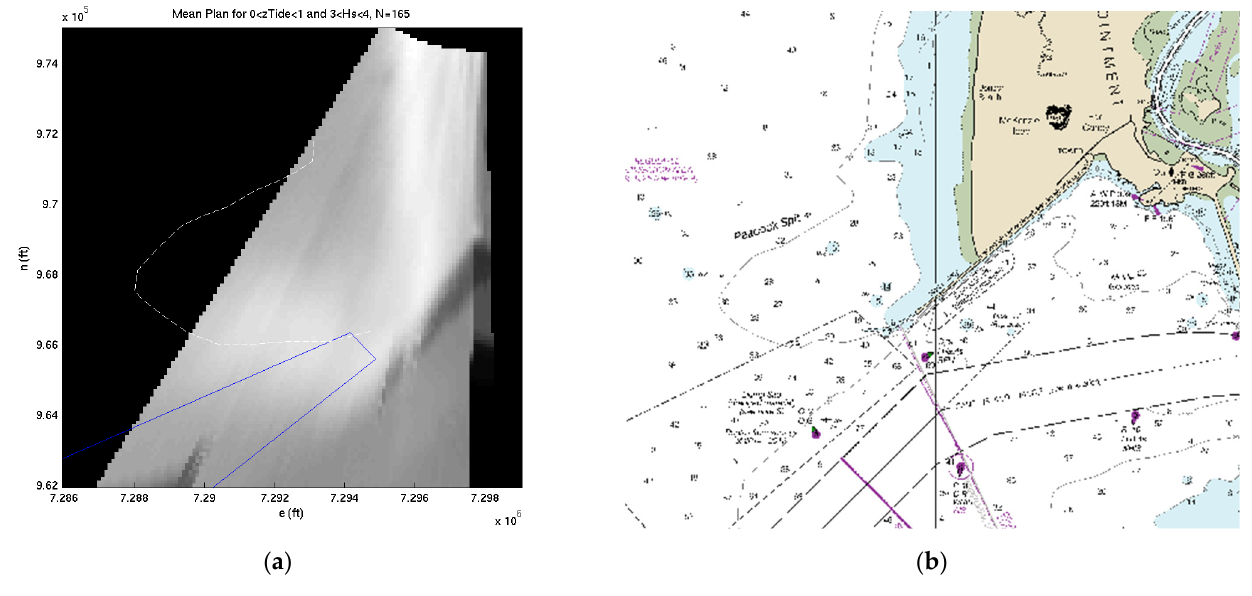
Figure 8. ( a ) Rectified (map) North Head re-projection of the panoramic view in Figure 5 onto Oregon state plane coordinates. The jetty is visible angling to the southwest. The SWS boundary is shown by the blue line and lies to the southwest of the band of enhanced wave breaking. ( b ) Nautical chart of the same region showing Peacock Spit on the north side of the jetty. The Peacock Spit boundary is reproduced in ( a ) and corresponds to the region of enhanced breaking.